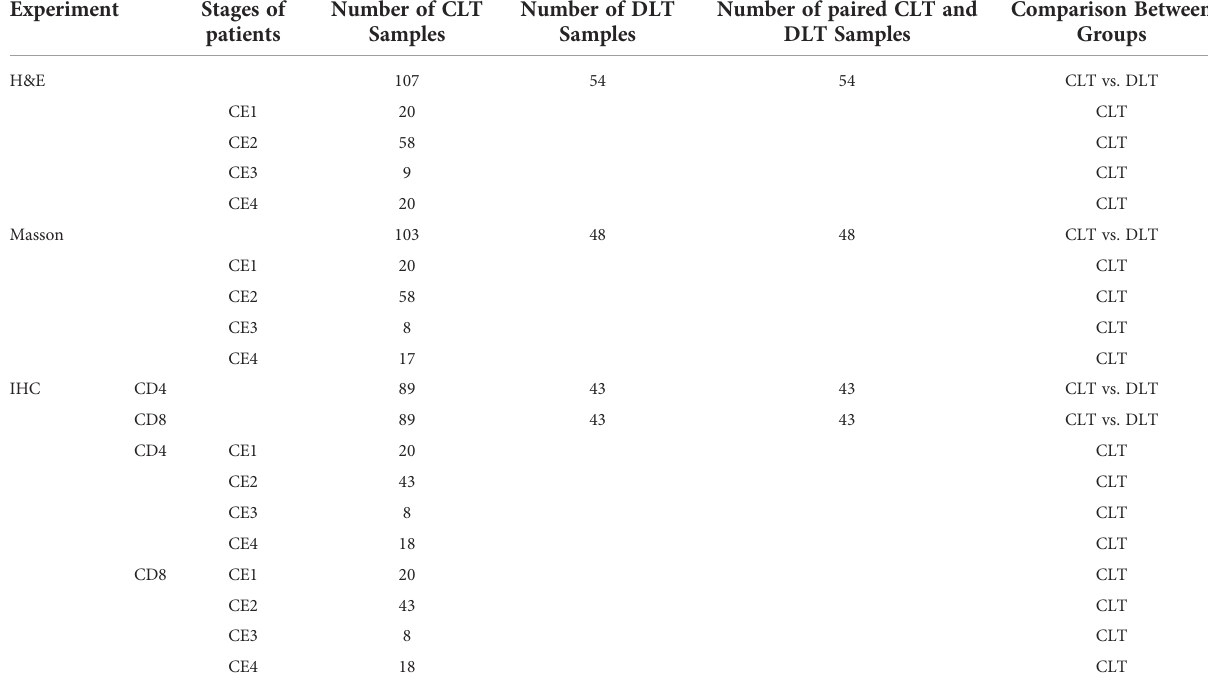
TABLE 1 Liver samples from patients with CE used for immunological